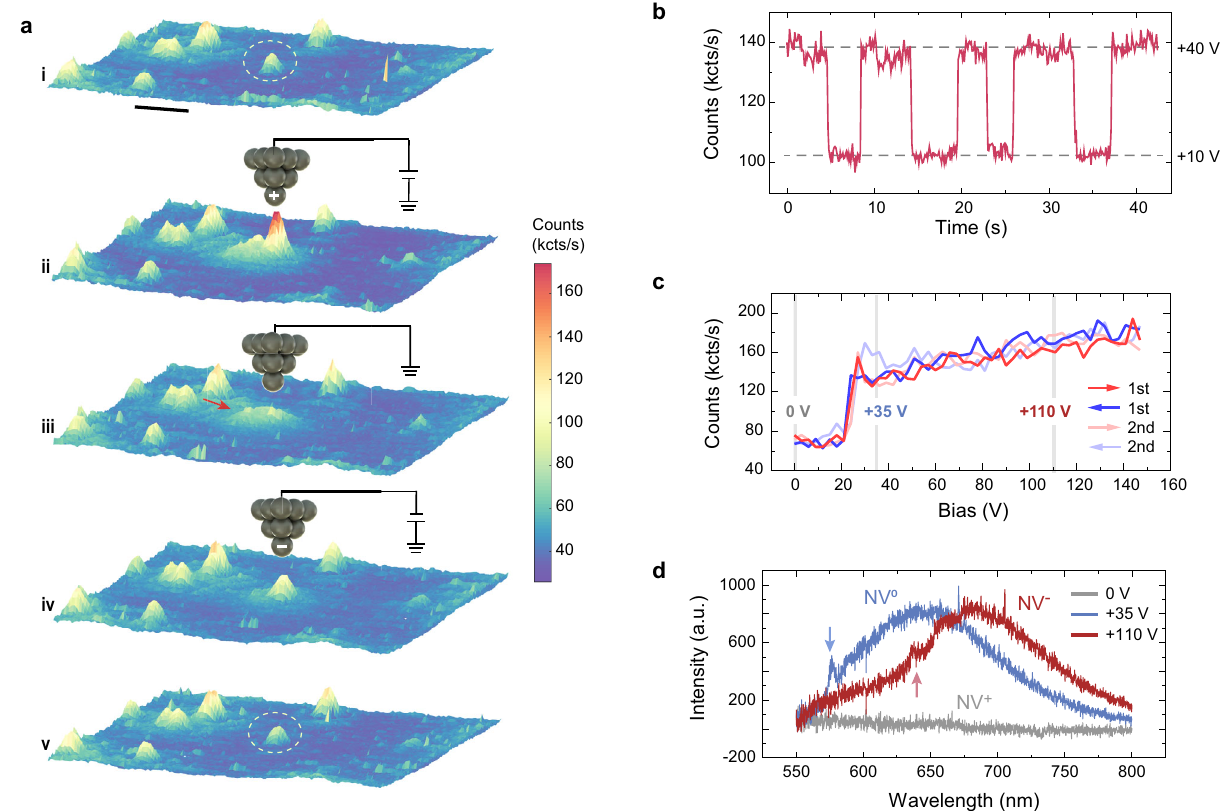
Fig. 3 Tip-induced charge-state transition of a single NV. a The process of charging the NV by local electric fi eld from the AFM tip. Scale bar: 1 μ m. (i) Confocal image including the target NV denoted by a dashed white ellipse before the charge state control. (ii) The tip with a high positive bias was guided close to the target NV, and the fl uorescence of NV preserved. (iii) When the tip was grounded, the NV became completely dark. The small background denoted by red arrow arises from the tip-scattered light. (iv) Applying a high negative voltage to the tip switched the NV to bright state as before. (v) The bright state of NV remains when the tip was grounded and retracted. b Time-elapsed fl uorescence shows the fast switch of NV charge state when the bias was set at + 40 or + 10 V alternatively. c Fluorescence-bias curves in the positive voltage range. Reproducible curves along with two cycles of bias ramps indicate the charge state control with high fi delity. d PL spectra of the same NV in ( c ) under different biases, con fi rming the different charge states of NV. The blue and red arrows indicate the ZPL of NV 0 and NV − , respectively. All the fl uorescence data were recorded under the 488-nm excitation laser with the 550-nm LP fi